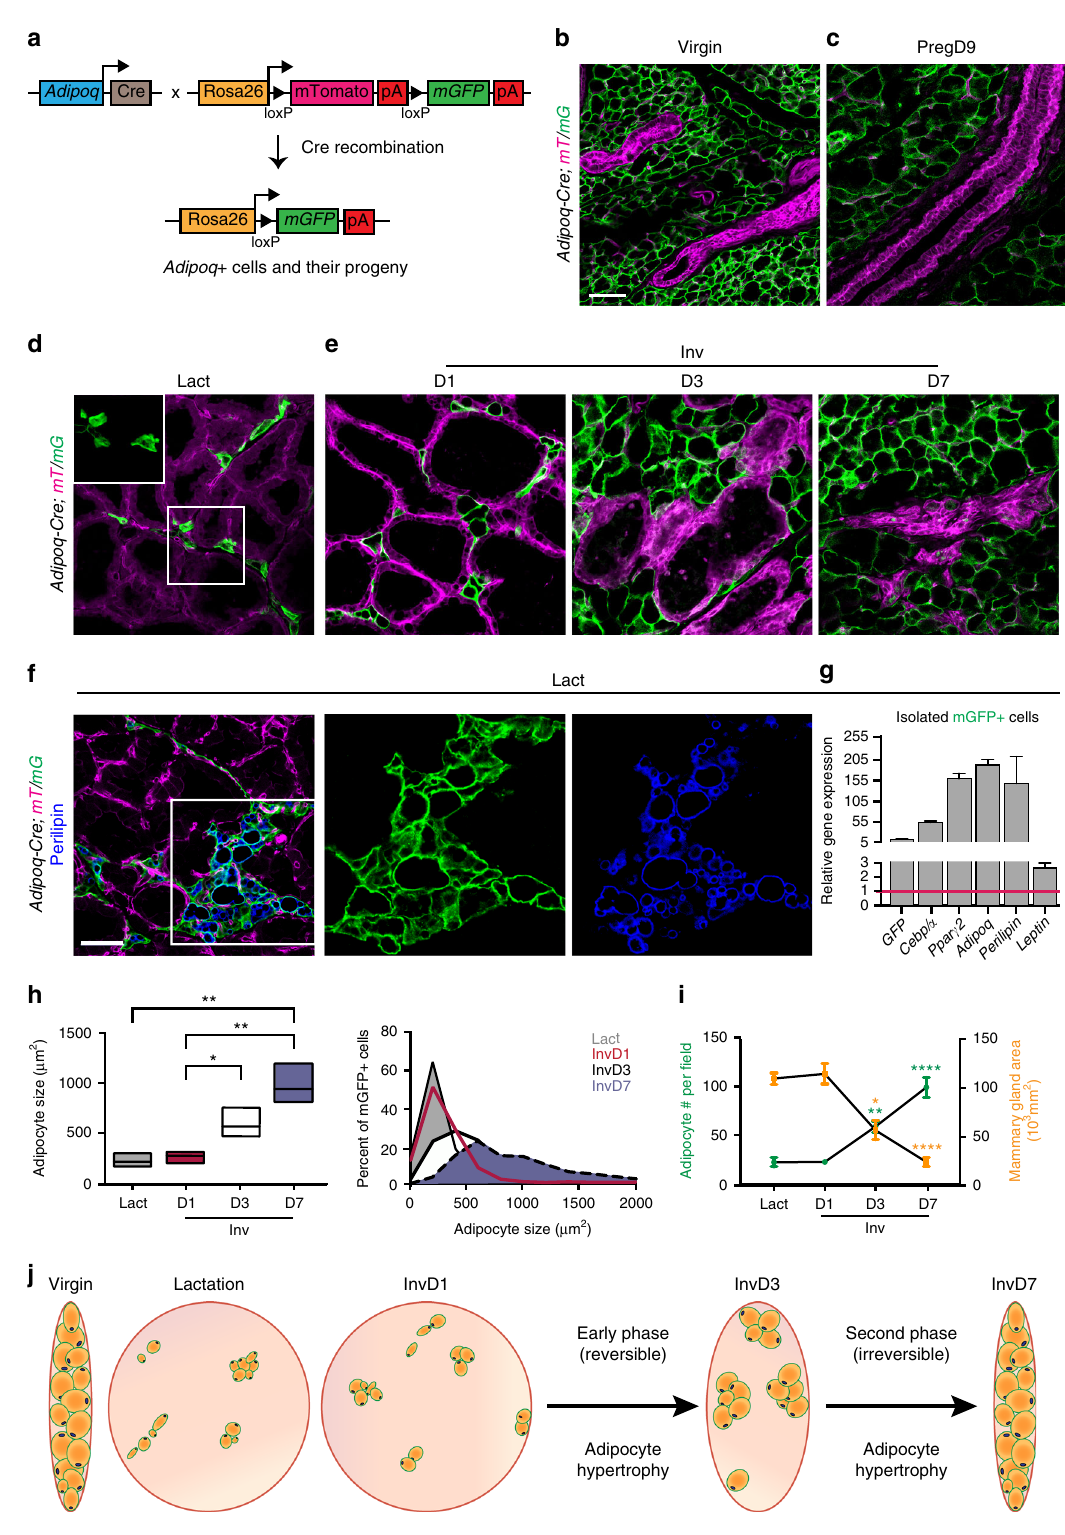
cells 34,35 — with mGFP (Fig. 2a). Whole-mount images of large regions of the MG from K14-Cre; mT/mG mice during pregnancy revealed that the majority of epithelial ducts express mGFP (Fig. 2b). During pregnancy, 85.9% of K8 + luminal and 87.9% of K14 + myoepithelial lineages expressed mGFP in these mice (Fig. 2c, e), which is consistent with previous